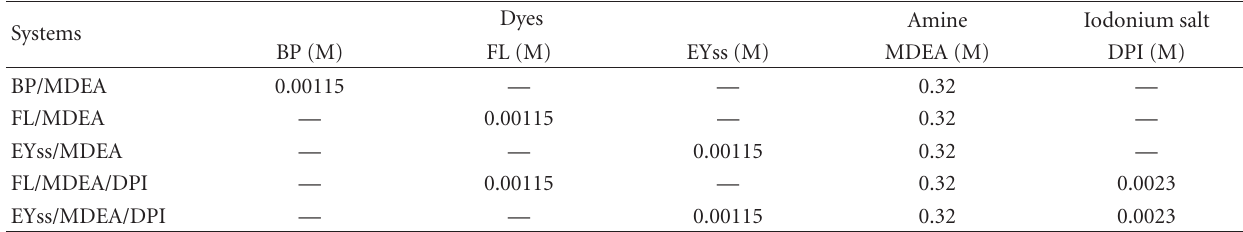
Table 1: Molar concentration of components in the photoinitiator systems under